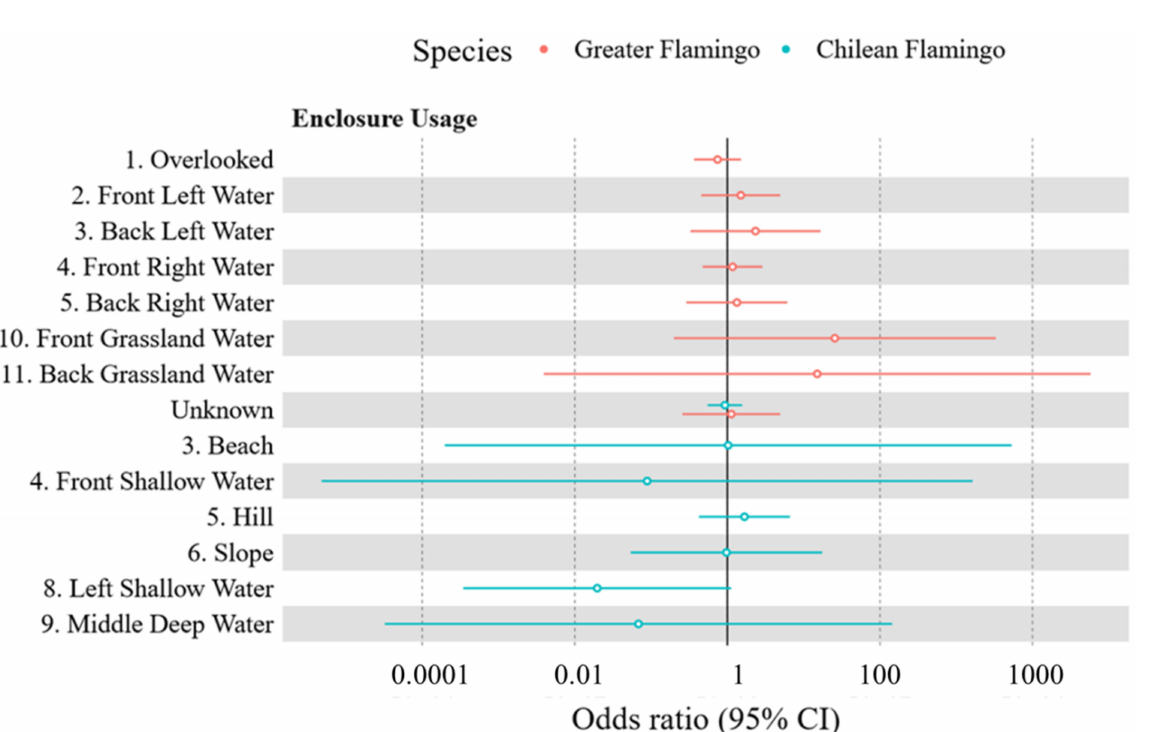
Figure 6. Mean zone occupancy % (stacked columns) and SPI (line plot) for the Greater and Chilean Flamingo flock across each observation period for zoo status. Error bars represent the variation (SE ± ) in mean occupancy. Greater Flamingos spent most of their time in zone 1 Overlooked and zone 4 FRW. Chilean Flamingos mostly occupied zone 5 Hill and increased occupancy of zone 5 Hill increased when the zoo reopened. The SPI different zoo status showed a decreasing trend for the Greater Flamingo flock and an increasing trend for the Chilean Flamingo flock. ( a ): FLW = front left water; BLW = back left water; FRW = front right water; BRW = back right water. ( b ): FSW = front shallow water; CC = canopy cover; LSW = left shallow water; MDW = middle deep water.